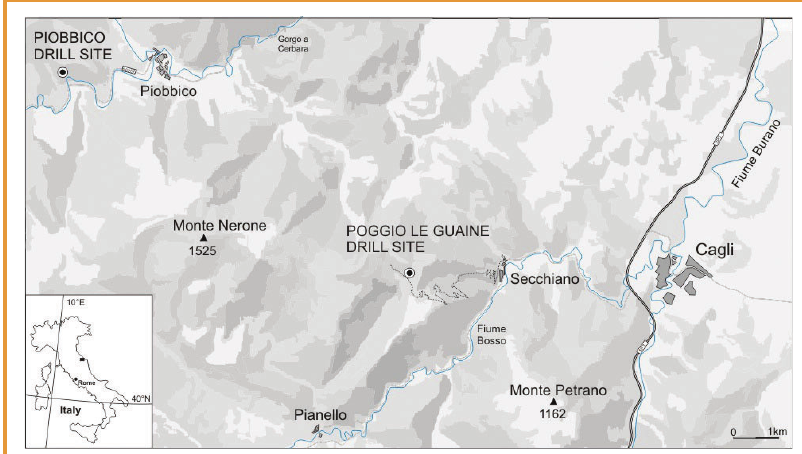
Figure 1. Location of the Poggio le Guaine drill site in the Umbria-Marche Basin (northern Apennines, central Italy). The location of the Piobbico drill site—where an 84-m-thick core extending from the upper Albian down to the uppermost Barremian was drilled in 1982—is also